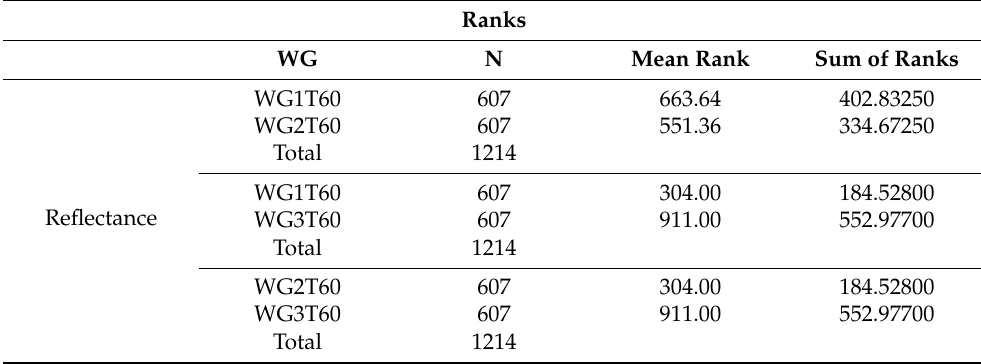
Table A13. Ranks table of Mann–Whitney U test for specular solar reflectance, according to the holding time of 60 min.